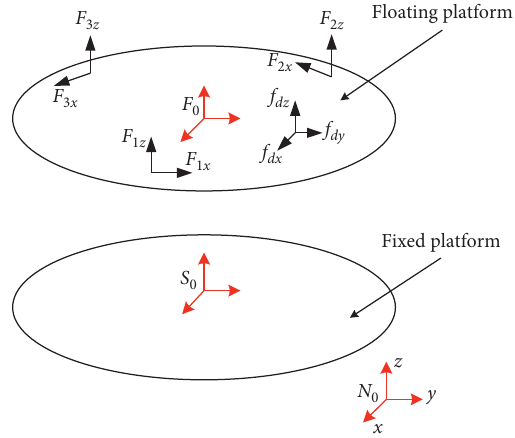
Figure 4: Force analysis of the floating platform.